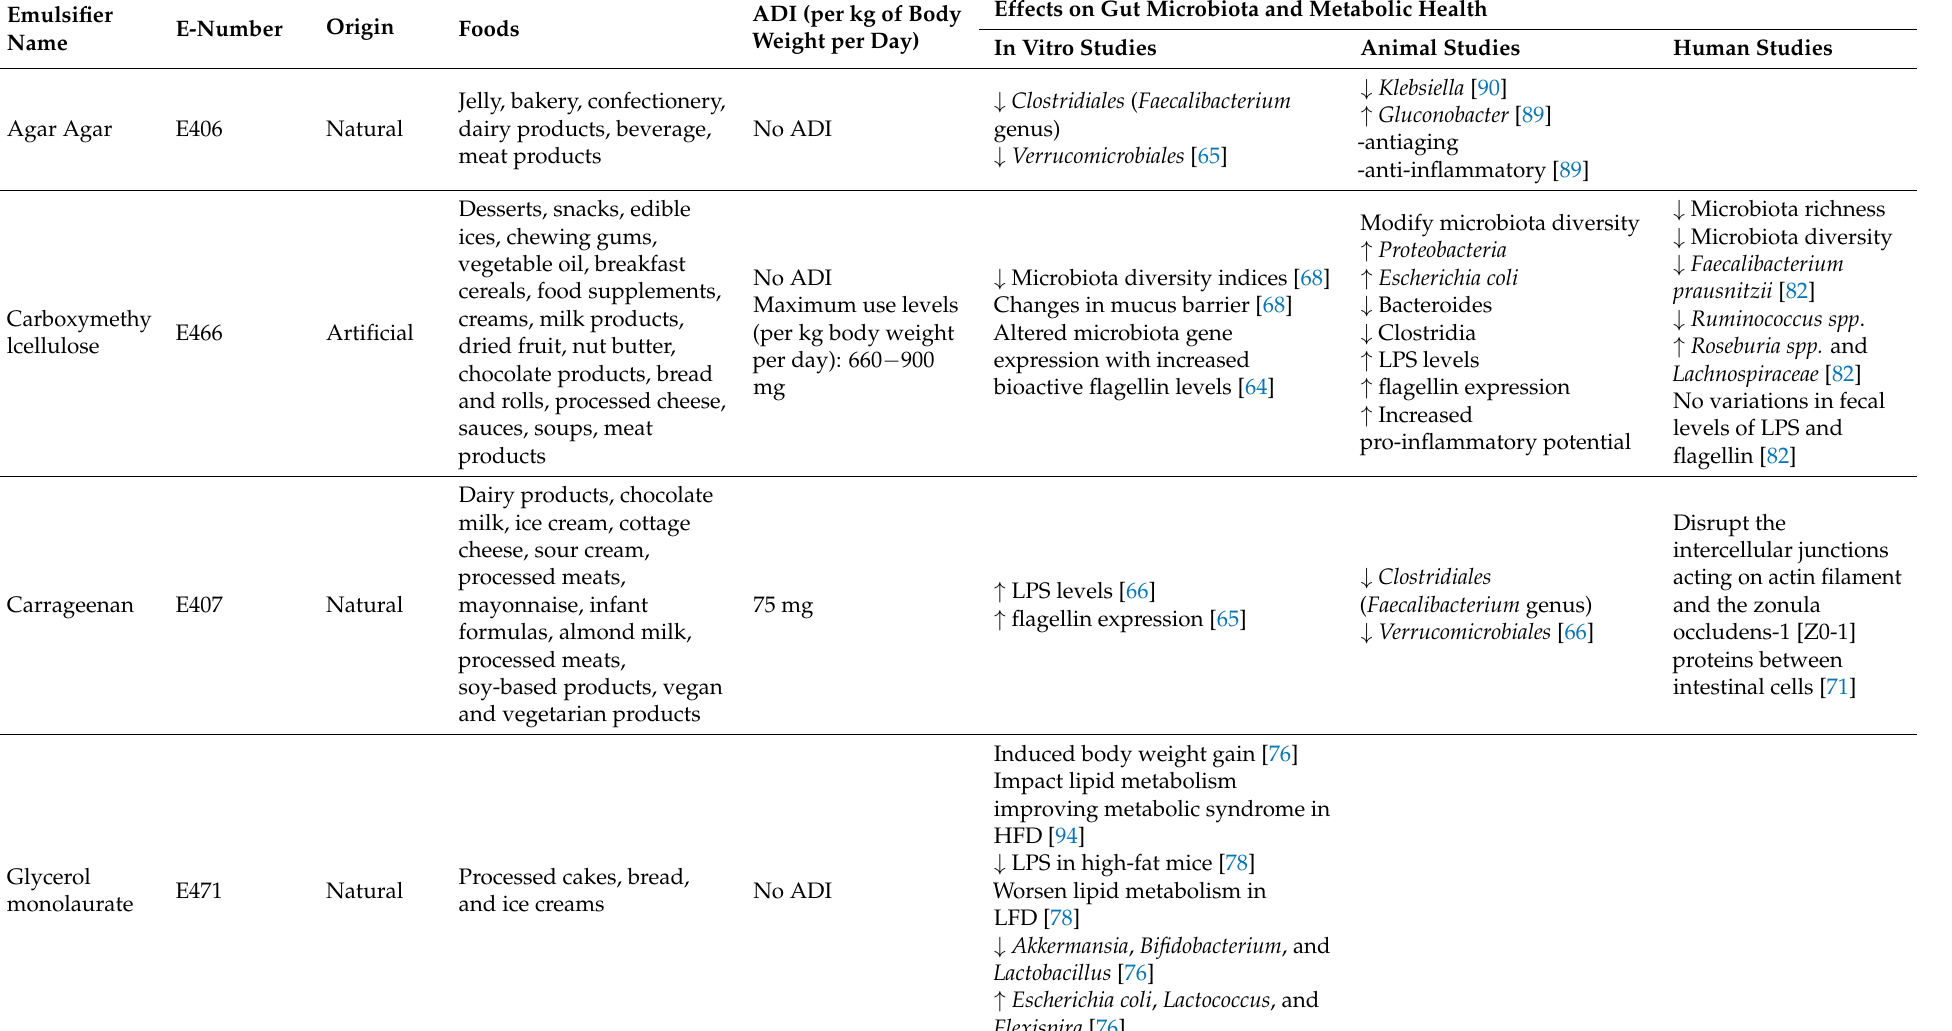
Table 1. Dietary Emulsifiers and their associations with composition and functions of the gut microbiota in in vitro, in vivo, and human